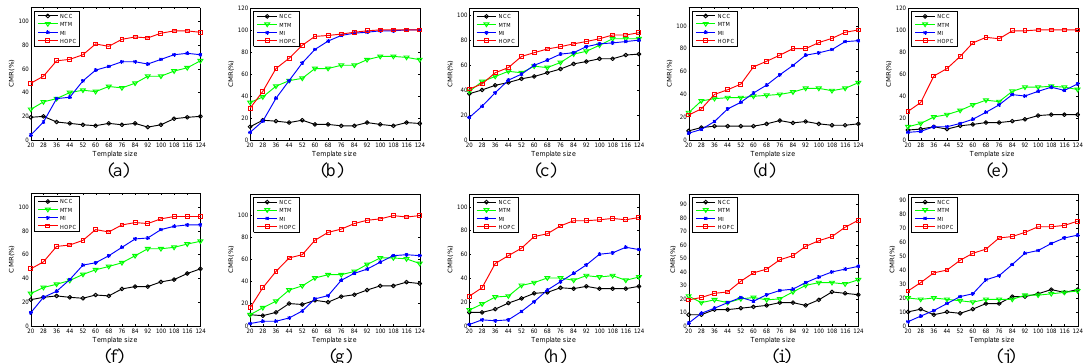
Figure 11. The CMRs of NCC, MTM, MI and HOPC. (a) test 1. (b) test 2. (c) test 3. (d) test 4. (e) test 5. (f) test 6. (g) test 7. (h) test 8. (i) test 9. (j) test